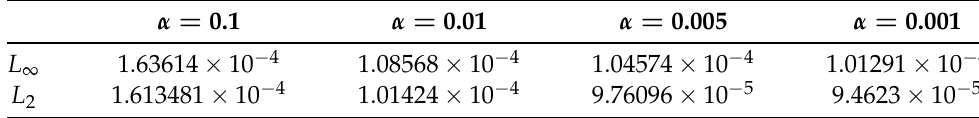
Table 5. Error norms of imaginary part of Equation (1) for τ = 0.005, N = 78, a = t =